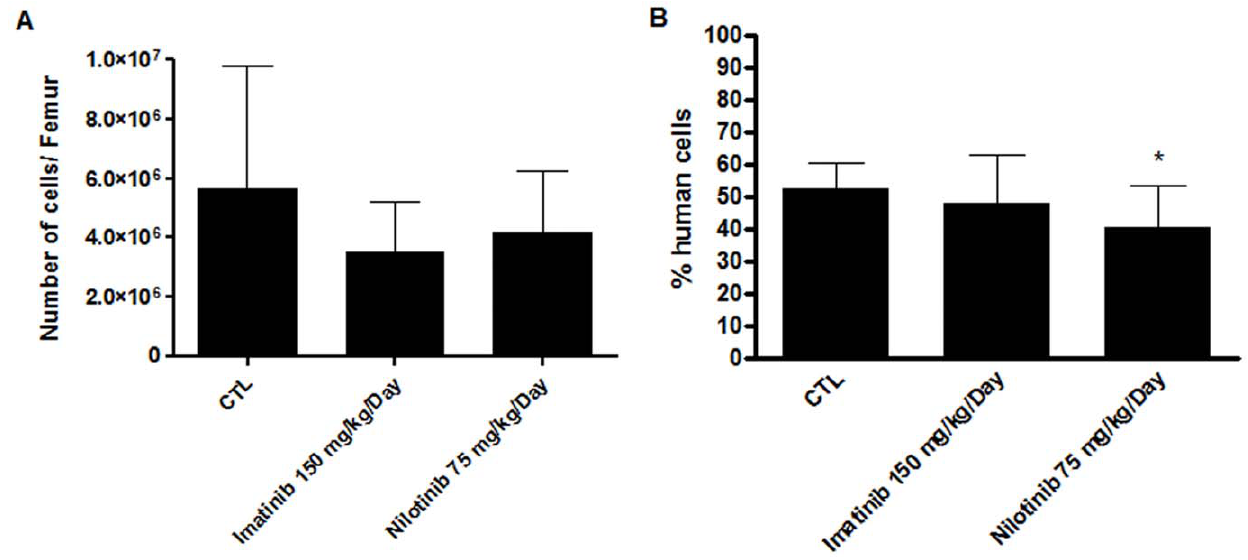
Figure 7. Effects of TKIs in a mouse model of transplantation. ( A ) : Daily doses of TKIs for 42 days did not affect bone marrow cellularity. Results are expressed as the mean number of cells per femur 6 SD. n $ 8, Student’s unpaired t tests. ( B ) : Effect of continuous administration of TKIs on bone marrow chimerism. Imatinib did not affect the percentage of human cells in the bone marrow while nilotinib slightly decreased it compared to the control group. Results are expressed as the mean percentage 6 SD. n $ 8, *p=0.0314 versus CTL, Student’s unpaired t tests. CTL: control condition without TKIs.